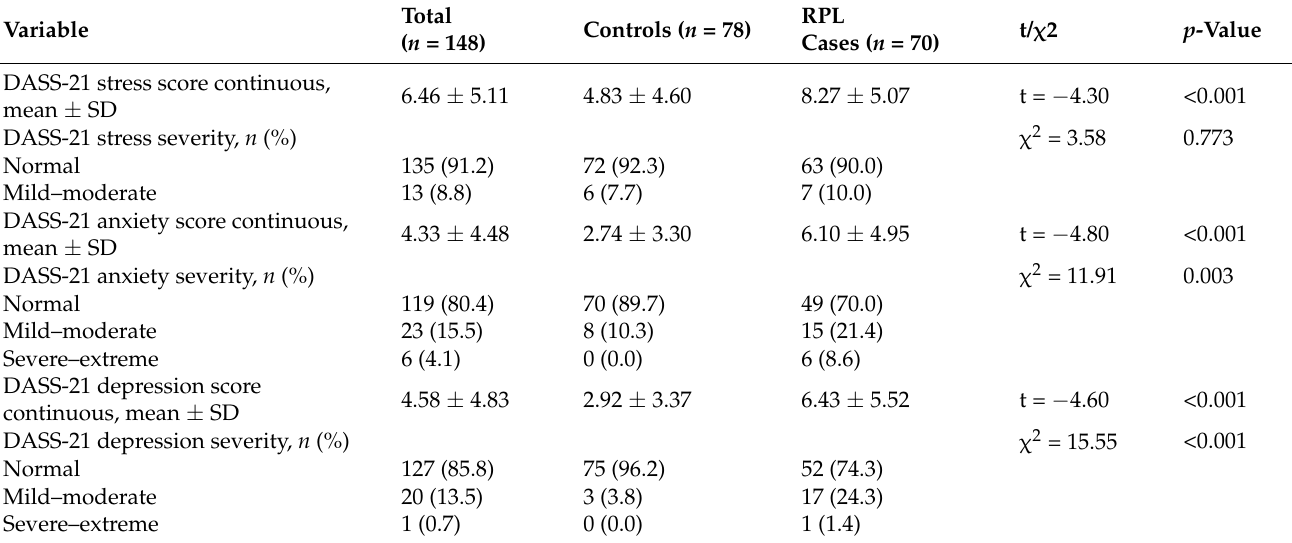
Table 2. Stress, depression, and anxiety levels among the study participants attended the National Research Center for Mother and Child Health, Astana, Kazakhstan.